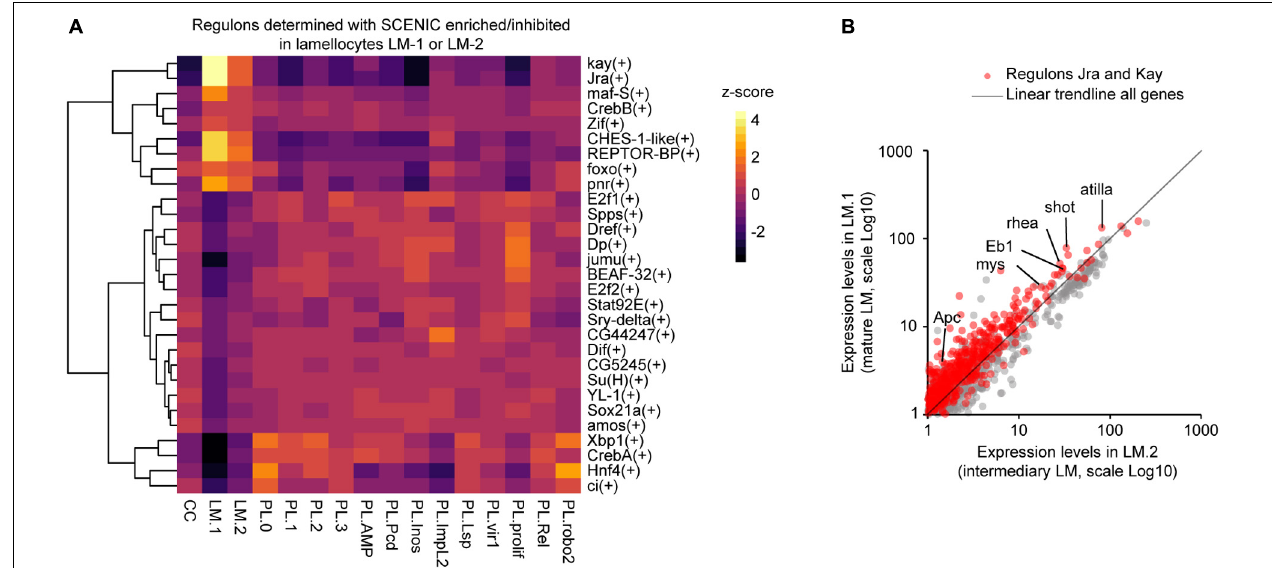
FIGURE 3 | Characterization of the regulatory network controlling lamellocyte differentiation. (A) Heatmap representing the z-score for the regulons enriched or underrepresented in the lamellocyte subgroups ( z -score > 2 or < -2) determined with SCENIC. The dendrogram on the left side of the panel indicates the correlation between the regulons across the dataset. The z -score is indicated with a gradient from black ( z -score < 0, underrepresented regulons) to red and then yellow ( z -score > 0, overrepresented regulons). (B) Scatter plot comparing the pseudo-transcriptomes of mature lamellocytes (y-axis) and transient intermediary lamellocytes (x-axis). The pseudo-transcriptomes were generated from the dataset obtained upon wasp infestation (Cattenoz et al., 2020). The genes belonging to the regulons Jra and Kay are indicated in red, the trendline of all genes expressions is in black, the axes are in Log10